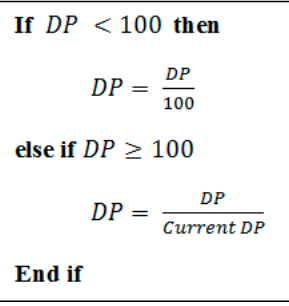
Figure 4. Requirement for dispersion percent ( DP ) .